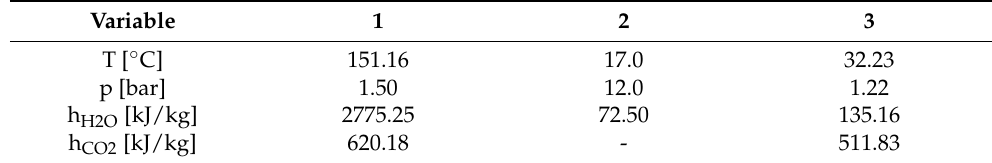
Table 11. Thermodynamic parameters of water, steam and CO 2 in characteristic points of a spray ejector